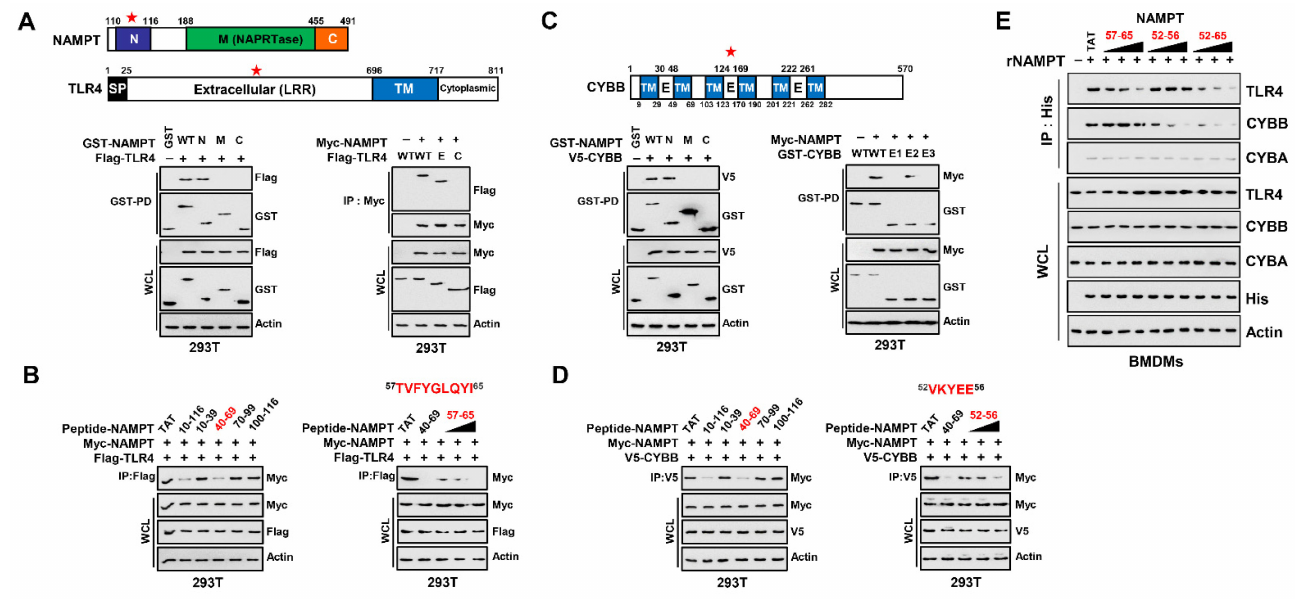
Figure 3. NAMPT (aa 57-65 and aa 52-65) is an essential region for binding to TLR4 and CYBB. ( A ) Schematic diagram of the structures of NAMPT and TLR4 (upper). The 293T cells were transfected with GST-NAMPT or its mutants and Flag-TLR4. 293T cells were subjected to GST pull-down, followed by IB with α Flag. WCLs were used for IB with α GST, α Flag or α Actin (lower, left). The 293T cells were transfected with Flag-TLR4 or its mutants and Myc-NAMPT. The 293T cells were used for IP with α Myc, followed by IB with α Flag. WCLs were used for IB with α Myc, α Flag or α Actin (lower, right). ( B ) 293T cells were transfected with Myc-NAMPT and Flag-TLR4 and treated NAMPT peptide or its mutants for 6 h (5 µ M, left; 1, 5, 10 µ M, right). The 293T cells were used for IP with α Flag, followed by IB with α Myc. WCLs were used for IB with α Myc, α Flag or α Actin. ( C ) Schematic diagram of the structures of CYBB (upper). The 293T cells were transfected with GST-NAMPT or its mutants and V5-CYBB (lower, left). The 293T cells were transfected with GST-CYBB or its mutants and Myc-NAMPT (lower, right). The 293T cells were subjected to GST pull-down, followed by IB with α V5 or α Myc. WCLs were used for IB with α GST, α Myc, α V5 or α Actin. ( D ) 293T cells were transfected with Myc-NAMPT and V5-CYBB and treated NAMPT peptide or its mutants for 6 h (5 µ M, left; 1, 5, 10 µ M, right). The 293T cells were used for IP with α V5, followed by IB with α Myc. WCLs were used for IB with α Myc, α Flag or α Actin. ( E ) BMDMs were incubated with rNAMPT (1, 5, 10 µ g/mL) for 2 hr. BMDMs were subjected to IP with α His, followed by IB with α TLR4, α CYBB or α CYBA. WCLs were used for IB with α TLR4, α CYBB or α CYBA, α His or α Actin. The data come from seven independent experiments that yielded comparable results ( A – E ). Ref star: Binding